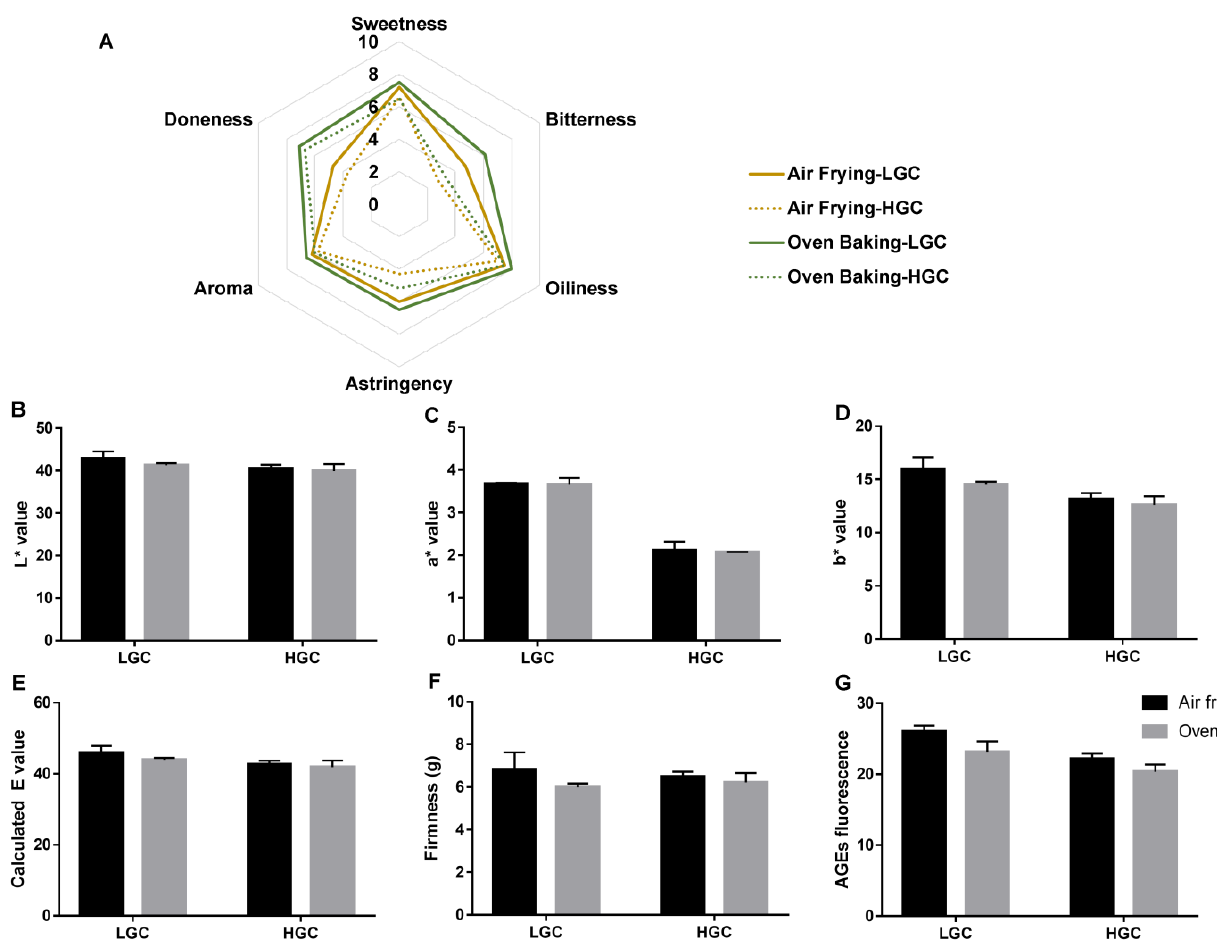
Figure 2. Green tea fortification removed the difference between air-fried and oven-baked cupcakes. ( A ) Radar chart of sensory evaluation. ( B – D ) Lab value. ( E ) Calculated E value. ( F ) Firmness. ( G ) AGE fluorescence. LGC, the low level of green-tea-fortified cupcake; HGC, the high level of green-tea-fortified cupcake.